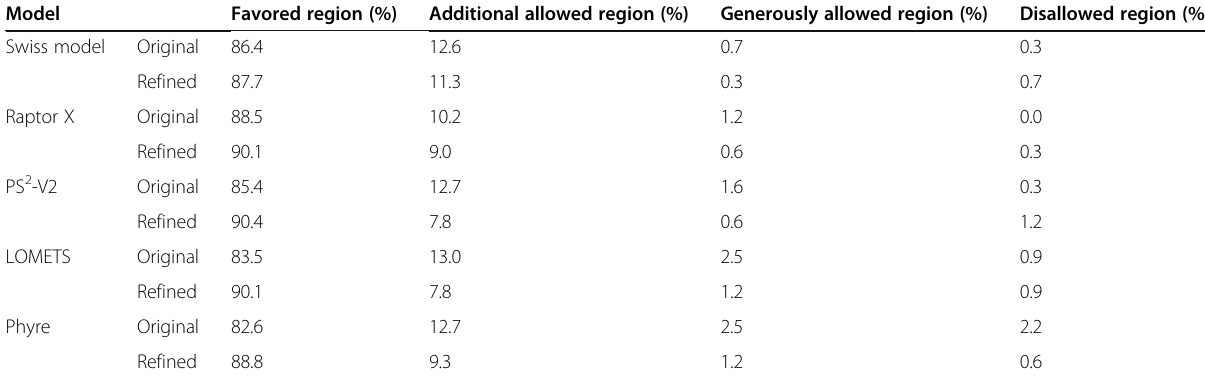
Table 5 The Ramachandran plot structure validation of original and refined structures Model